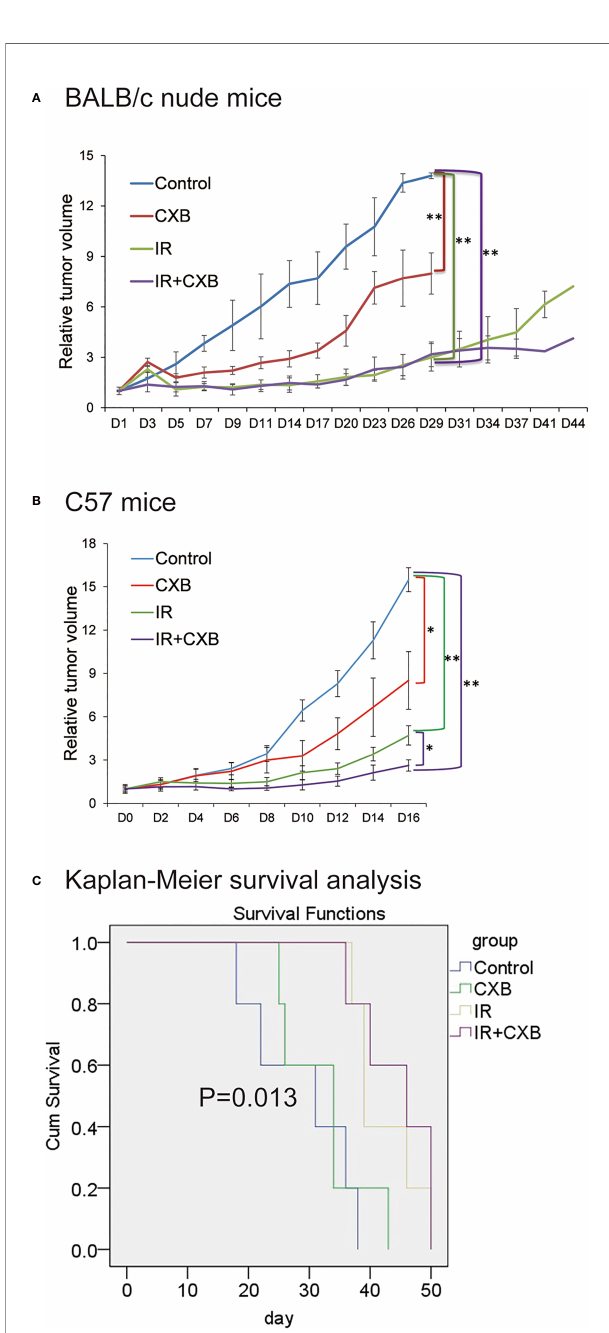
FIGURE 1 | CXB had radiosensitizing effect. BALB/c nude mice and C57 mice were randomly assigned to the control, CXB, IR, and IR plus CXB groups. (A) The tumor growth curve of BALB/c nude mice injected with H460 cells ( n = 6, each group). Compared with that in the control group, the tumor growth was signi fi cantly inhibited in IR plus CXB group in xenografts. Comparison with the control group: * p < 0.05 and ** p < 0.01. (B) Tumor formation experiments in C57 mice bearing LLC xenografts ( n = 6, each group). Data are expressed as the mean ± SD. The tumor growth was signi fi cantly inhibited in IR plus CXB group in xenografts. Comparison with the control group: * p < 0.05 and ** p < 0.01. (C) Survival analysis of C57 mice bearing LLC xenografts, p = 0.013 among groups. CXB, celecoxib; IR, irradiation; LLC, Lewis lung